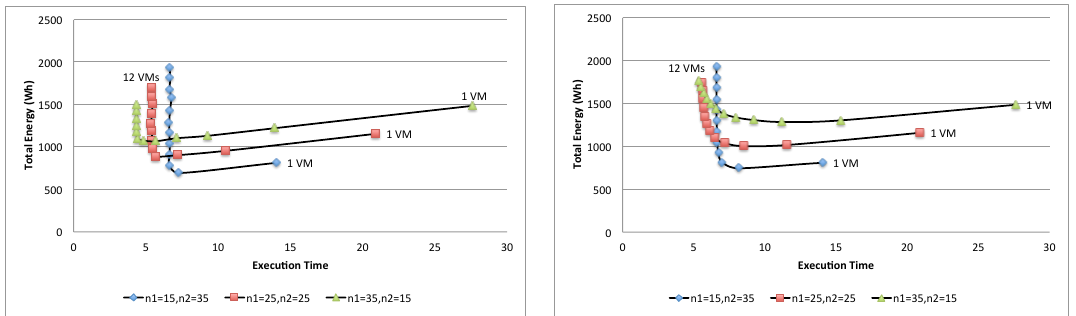
Figure 23. Energy per job with asynchronous ( left ) and synchronous ( right ) access for two-class workloads.